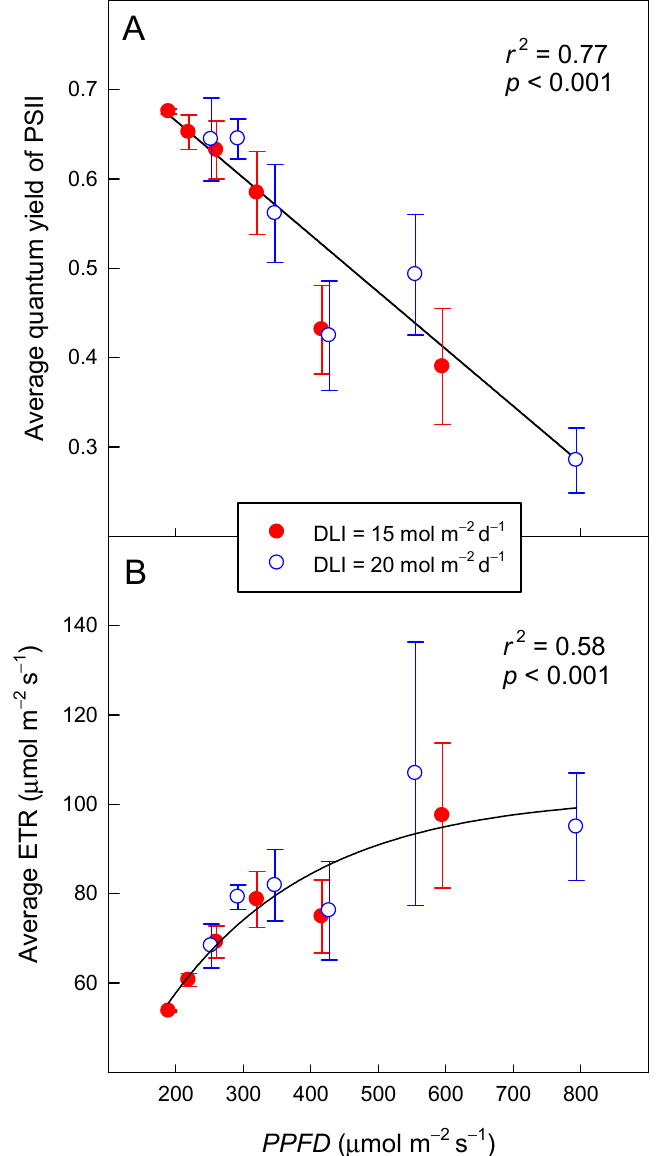
Figure 3. The quantum yield of photosystem II ( Φ PSII = 0.792 − 0.000663 × PPFD) ( A ) and the electron transport rate [ETR = − 10.1 + 112.1 × (1 − e − 0.00463 × PPFD )] ( B ) of lettuce ( Lactuca sativa ‘Green Towers’), averaged over the entire photoperiod, as a function of photosynthetic photon flux density (PPFD) Data points represent the mean ± SD (n = 3). Plants were measured under two daily light integrals (DLI), 15 and 20 mol m − 2 d − 1 , but DLI had no effect on the relationship between PPFD and these parameters.